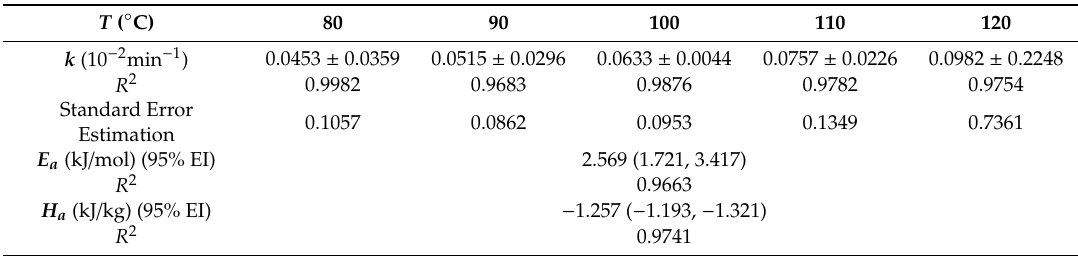
Table 6. The degradation rate constants, activation energy and reaction heat of anthocyanins in berry puree at di ff erent temperatures.